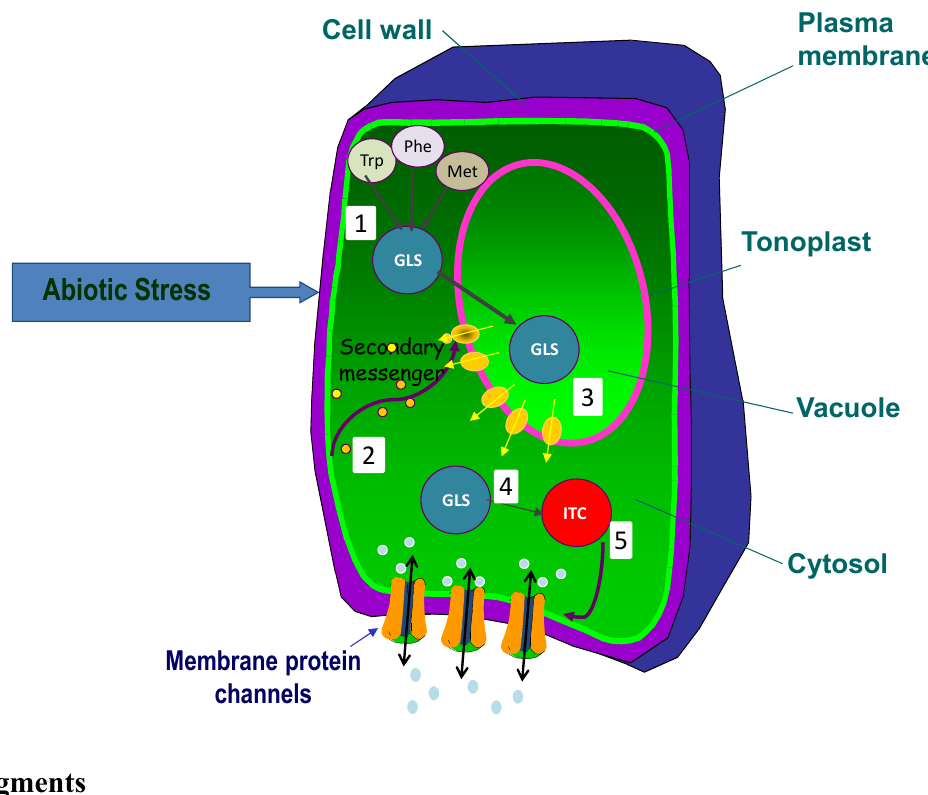
Figure 1. Effect of abiotic stress on glucosinolates (GLS)/allyl-isothiocyanates (ITC) content. (1) The chain-elongation steps of glucosinolates biosynthesis are affected by abiotic stress; (2) Stress perception may lead to increased synthesis of any secondary messenger in the cytosol, facilitating the release of the glucosinolates to the cytoplasm from the vacuole (3). The activity of plant myrosinases will product (allyl-) isothiocyanates (4) that might regulate the transduction or accumulation of other transporters or channels in the plasma membrane